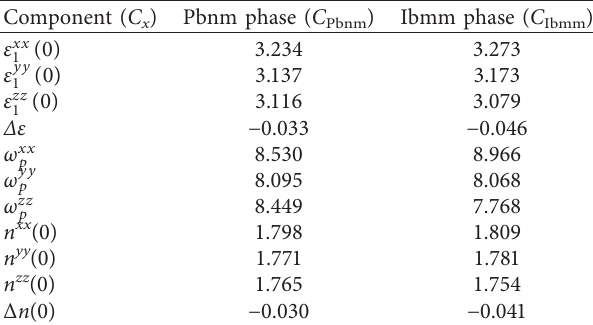
Table 2: Values of components for phases Pbnm and